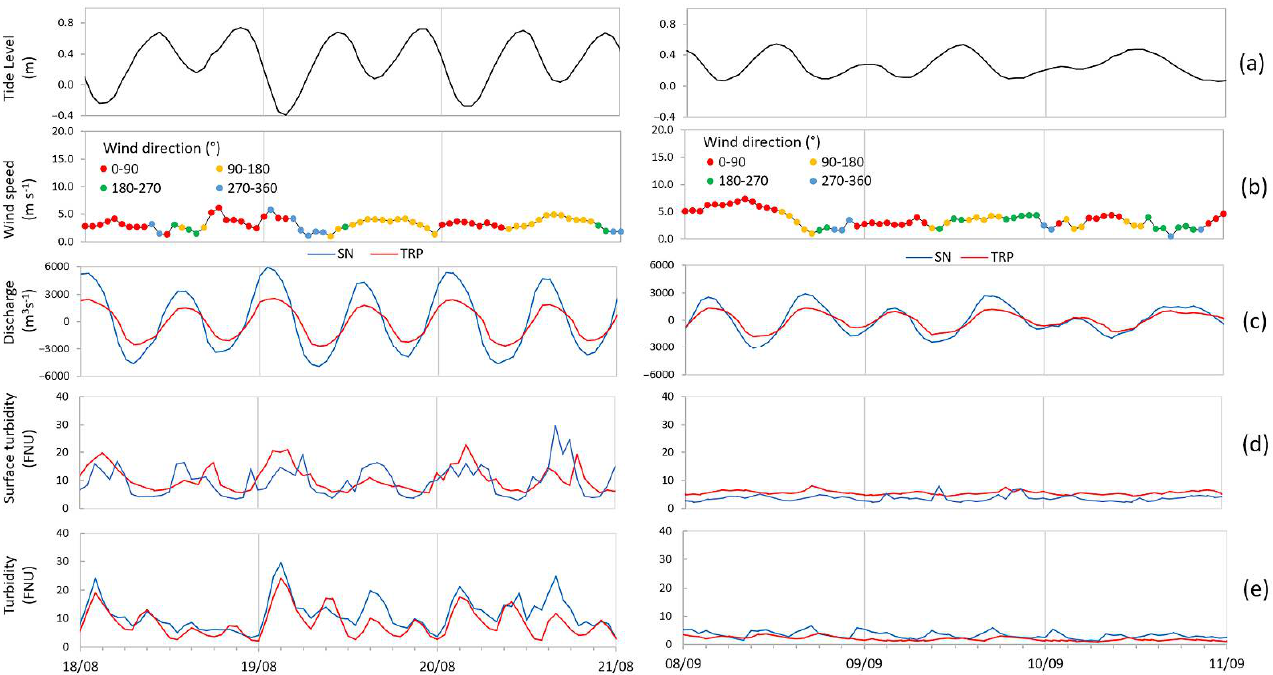
Figure 8. Subset of the time series presented in Figure 7. Left panel: from 18th to 20th August 2020. Right panel: from 8th to 10th September. Hourly time series of tidal level ( a ) and wind speed and direction (red = 0 ◦ –90 ◦ , yellow = 90 ◦ –180 ◦ , green = 180 ◦ –270 ◦ , cyan = 270 ◦ –360 ◦ ) ( b ), measured at the Lido Sud station; time series of discharge estimated with the index-velocity method from data of the bottom-mounted ADCPs (positive values of discharge indicate a seaward flow) ( c ); time series of surficial turbidity measured at fixed TRP and SN stations. ( d ); the vertically averaged turbidity derived from the conversion of acoustic backscatter from the bottom-mounted ADCPs ( e ).